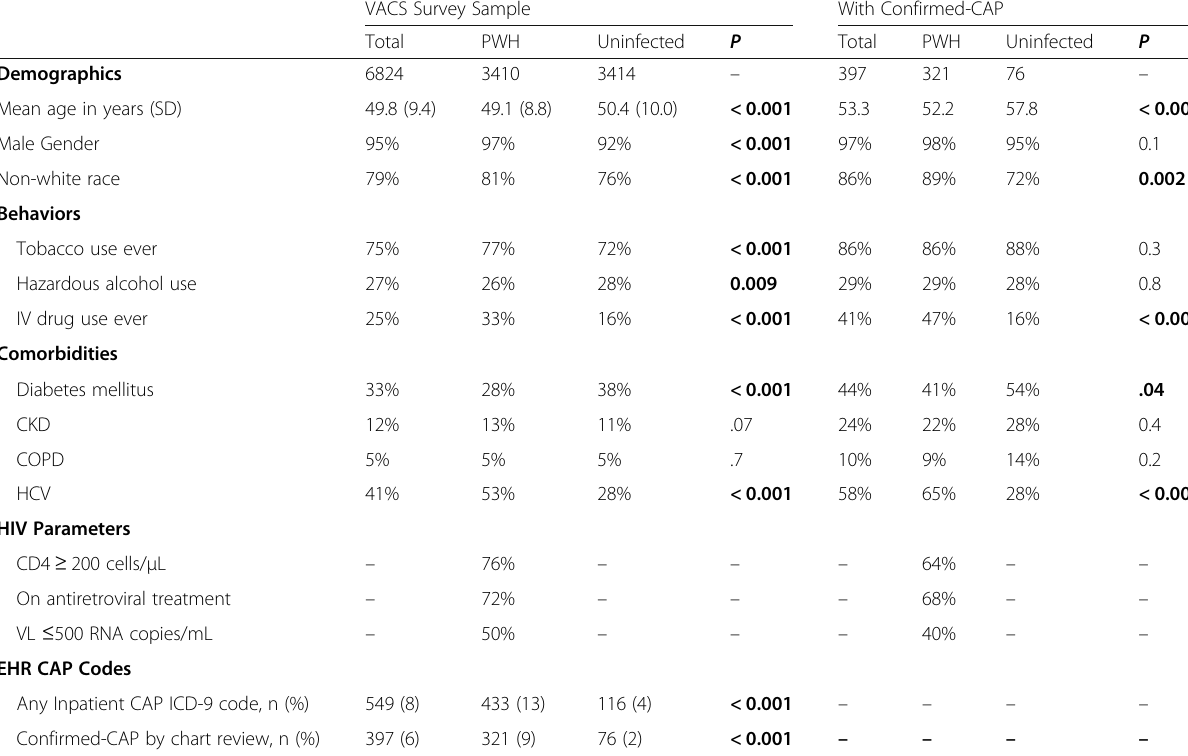
Table 1 Characteristics at baseline of VACS Patients enrolled in survey sample and of those with clinically confirmed community acquired pneumonia (confirmed-CAP) within the sample VACS Survey